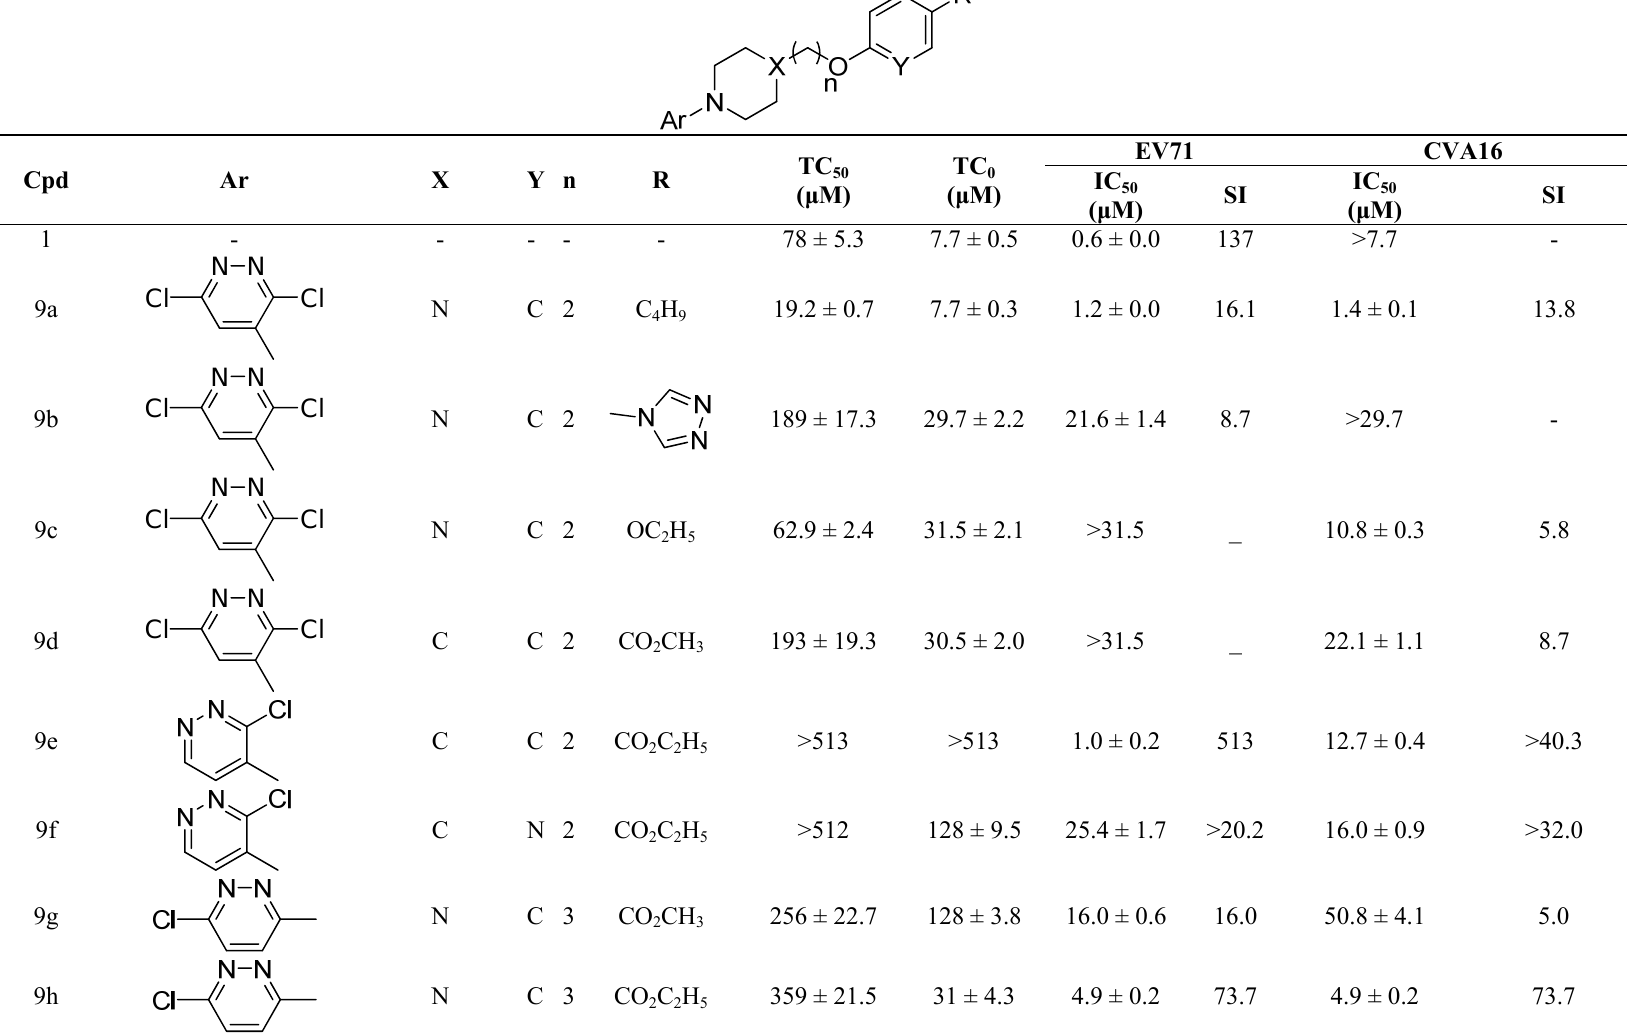
Table 1. Anti-EV71 activity, anti-CVA16 activity, and cytotoxicity of compounds 8a – f and compounds 9a – h